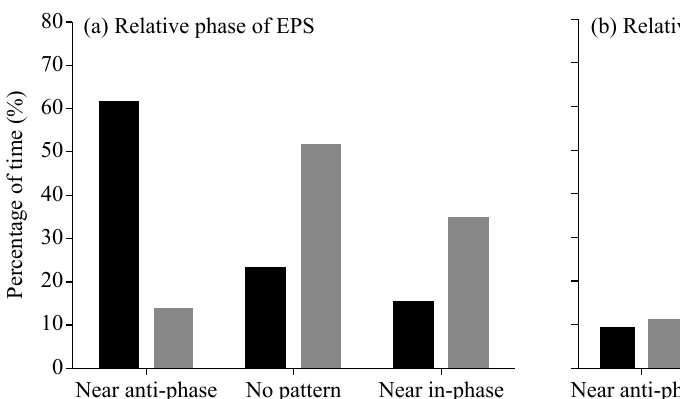
Figure 2. Relative phase of effective playing space (EPS) and length per width (LPW) ratio. Near in-phase represents the percentage of time spent in -30° to 30° bin. Near anti-phase represents the percentage of time spent in -150° to -180° bin and 150° to 180° bin. No pattern represents the percentage of time in all other